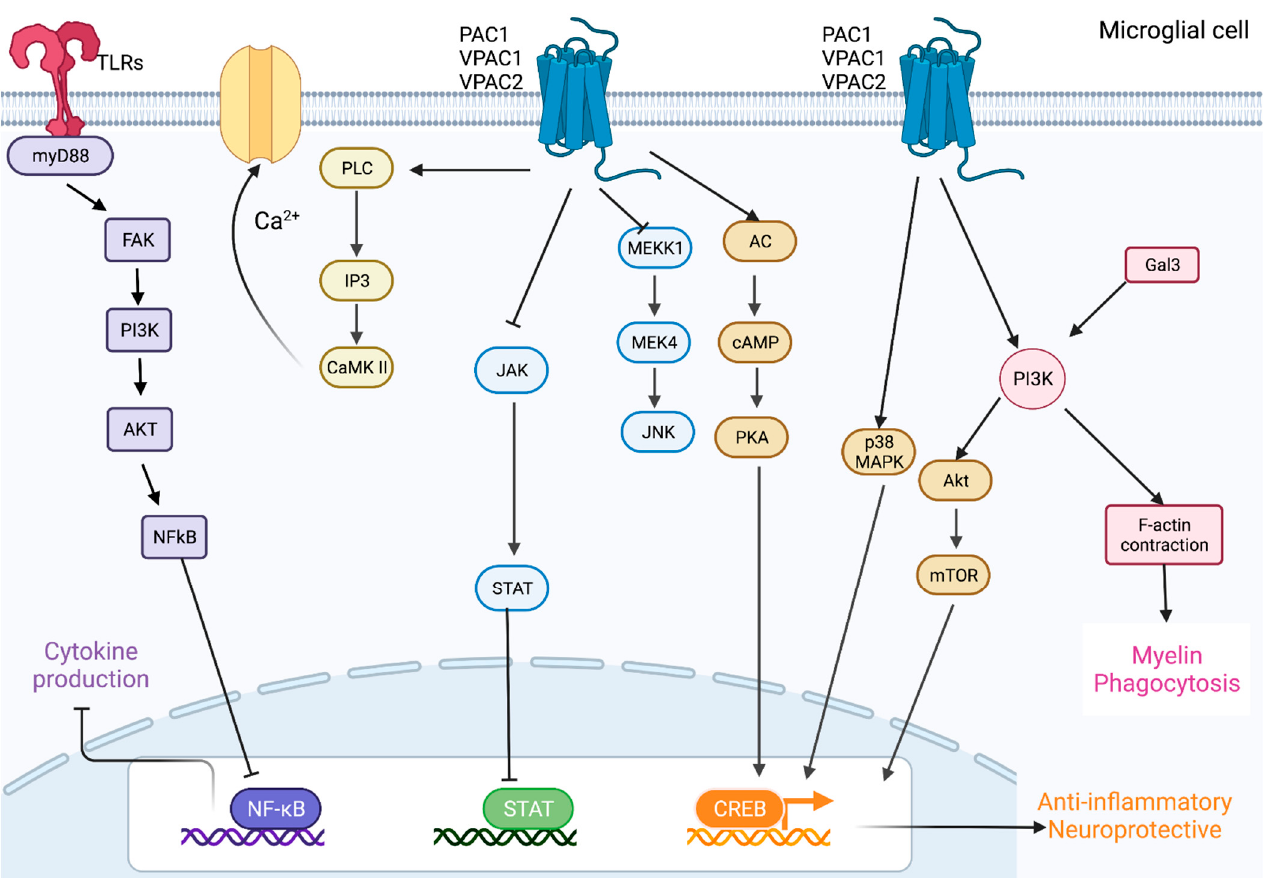
Figure 2. Schematic diagram of the signalling pathways activated by PACAP and VIP in microglia. In the figure, the molecular signalling pathways associated with microglial-mediated myelin debris phagocytosis are visualised. Briefly, myelin debris is recognised by TLRs, MerTK, TREM2, FC γ R, CR3, or SRA-AI/II receptors, which either stimulates the release of pro- and anti-inflammatory cytokines, influencing myelin phagocytosis, or activates several signalling pathways involved in the remodelling and contraction of the cytoskeleton, facilitating the engulfment of myelin debris. Both neuropeptides can counteract several pathogenic mechanisms triggered by